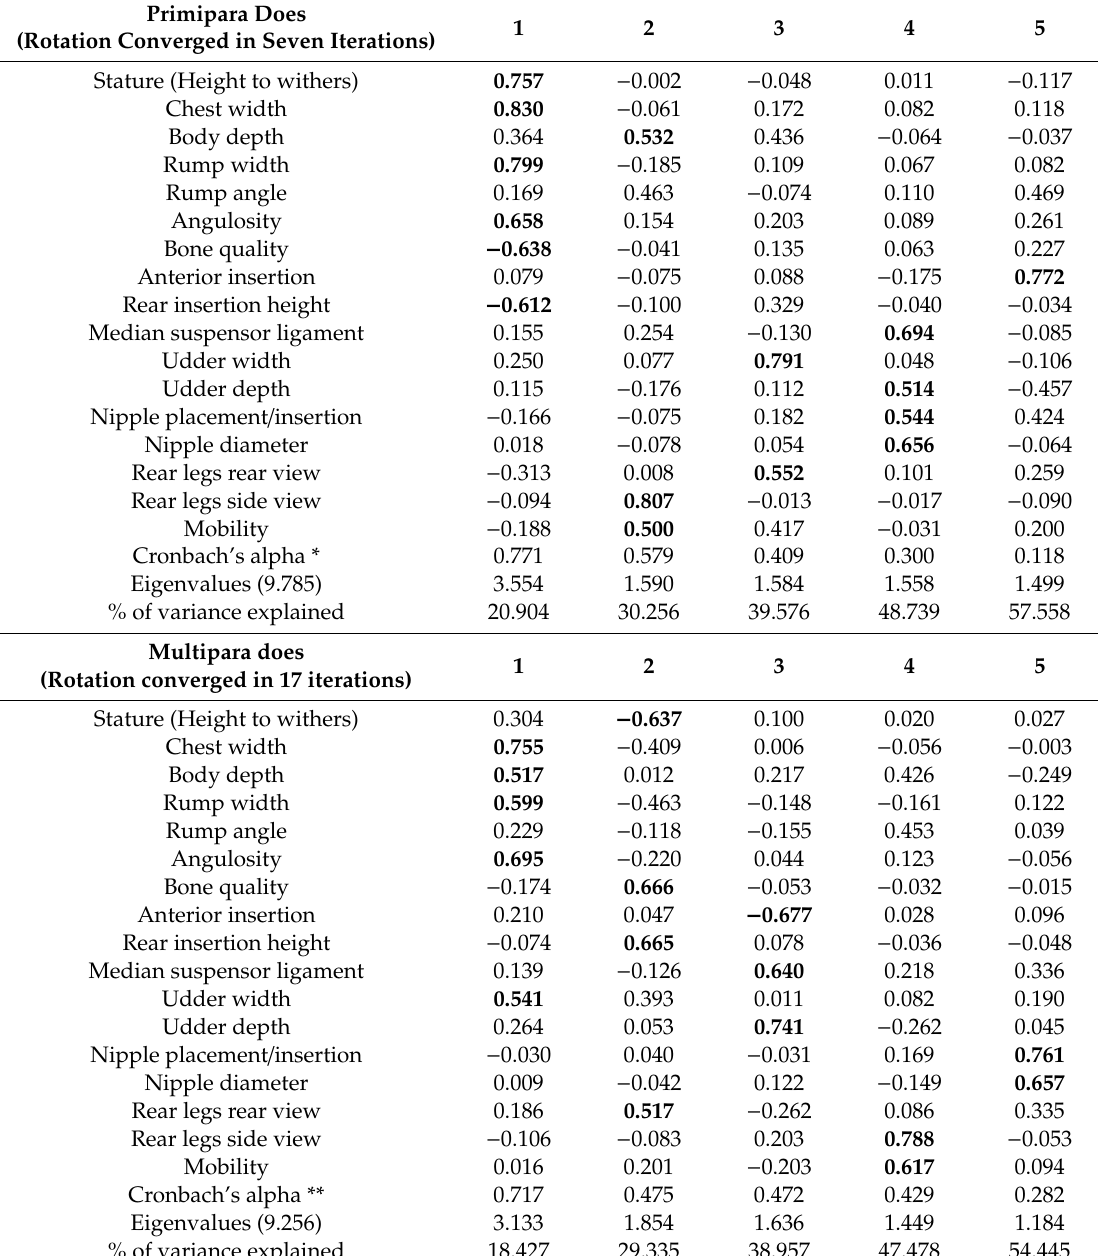
Table 2. LAS varimax with Kaiser normalization rotated component loadings, eigenvalues and percentages of variance explained for Murciano-Granadina primipara and multipara